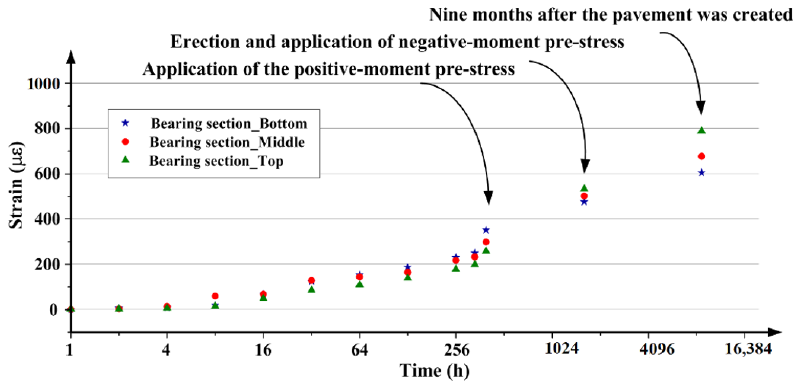
Figure 5. Monitored strain at the span-end cross-section.